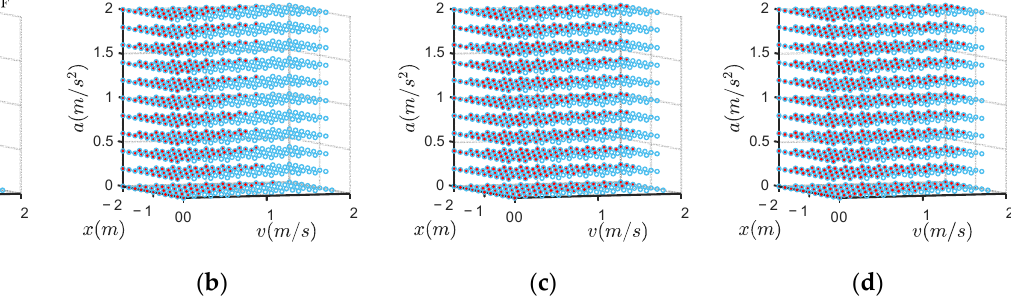
Figure 7. Feasibility comparison between MPC-OCBF and MPC-GCBF in the discrete-time formation: ( a ) γ = 0.05; ( b ) γ = 0.10; ( c ) γ = 0.15; ( d ) γ =